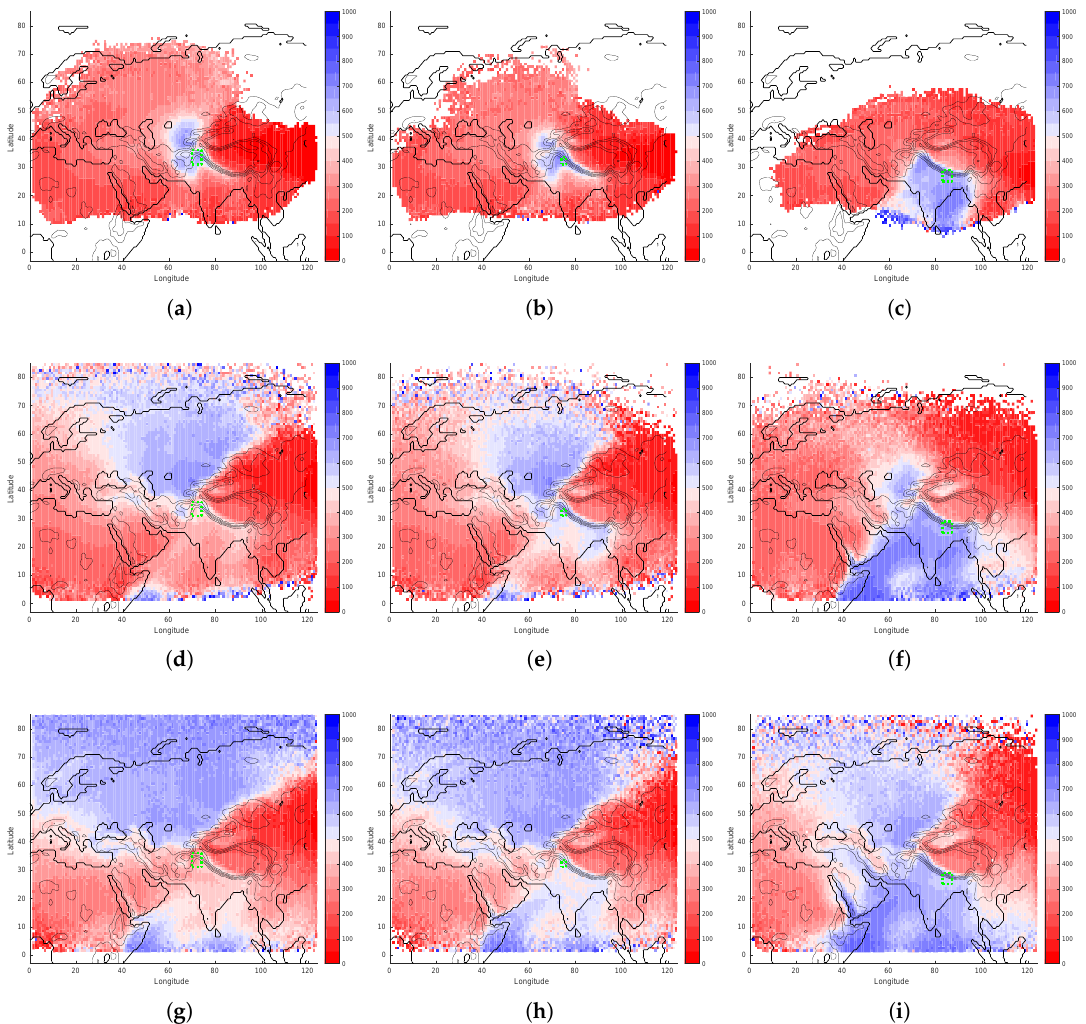
Figure 5. Summer (JJA) column mean climatology (1980–2016), of the parcel pressures, for all parcels over each 1 ◦ area, originating from: ( a ) NP , 2 days back in time, along the parcel trajectory; ( b ) U , 2 days back in time, along the parcel trajectory; ( c ) K , 2 days back in time, along the parcel trajectory; ( d ) NP , 6 days back in time, along the parcel trajectory; ( e ) U , 6 days back in time, along the parcel trajectory; ( f ) K , 6 days back in time, along the parcel trajectory; ( g ) NP , 10 days back in time, along the parcel trajectory; ( h ) U , 10 days back in time, along the parcel trajectory; ( i ) K , 10 days back in time, along the parcel trajectory. The area of interest is illustrated by a green dashed